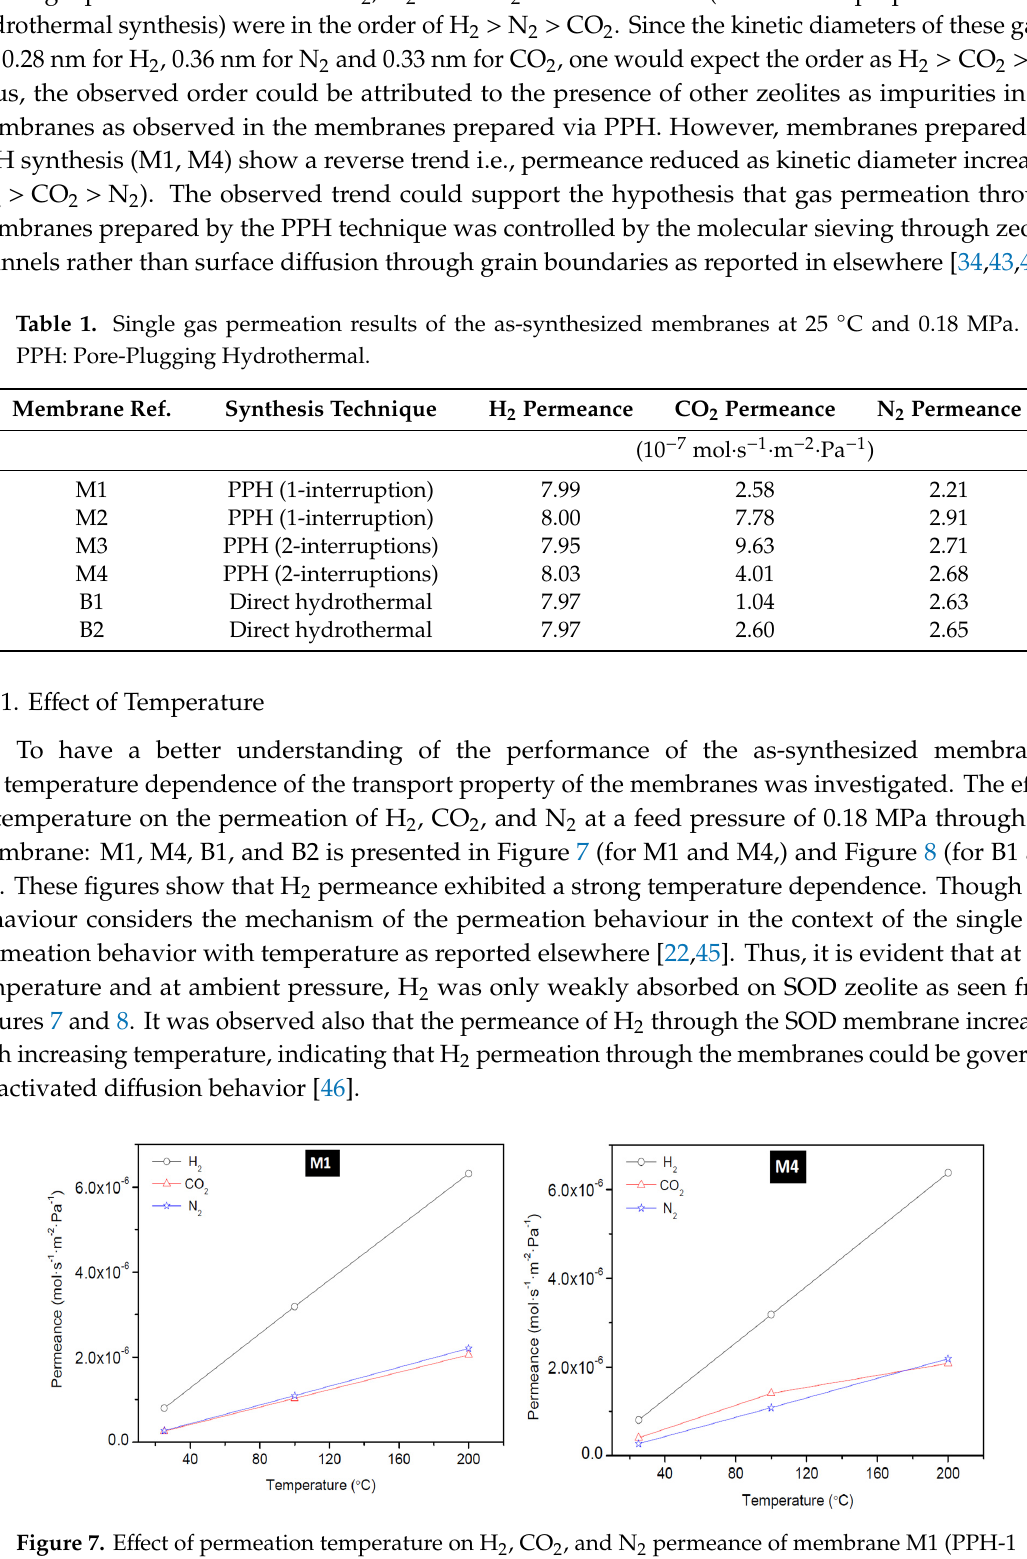
Figure 7. Effect of permeation temperature on H 2 , CO 2 , and N 2 permeance of membrane M1 (PPH-1 interruption) and M4 (PPH-2 interruptions). interruption) and M4 (PPH-2